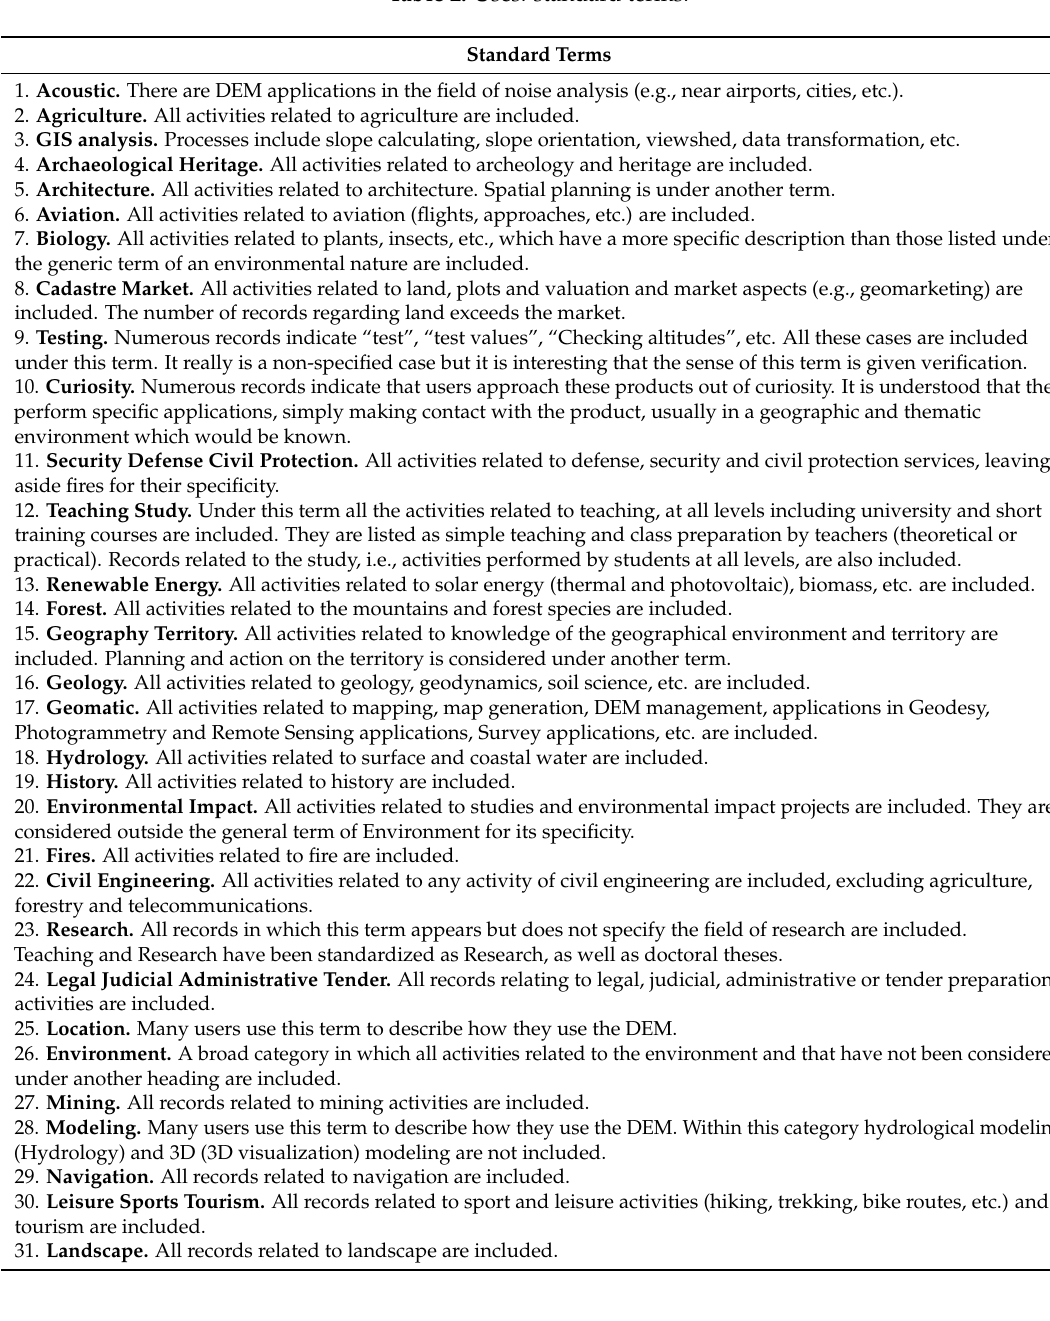
Table 2. Uses: standard